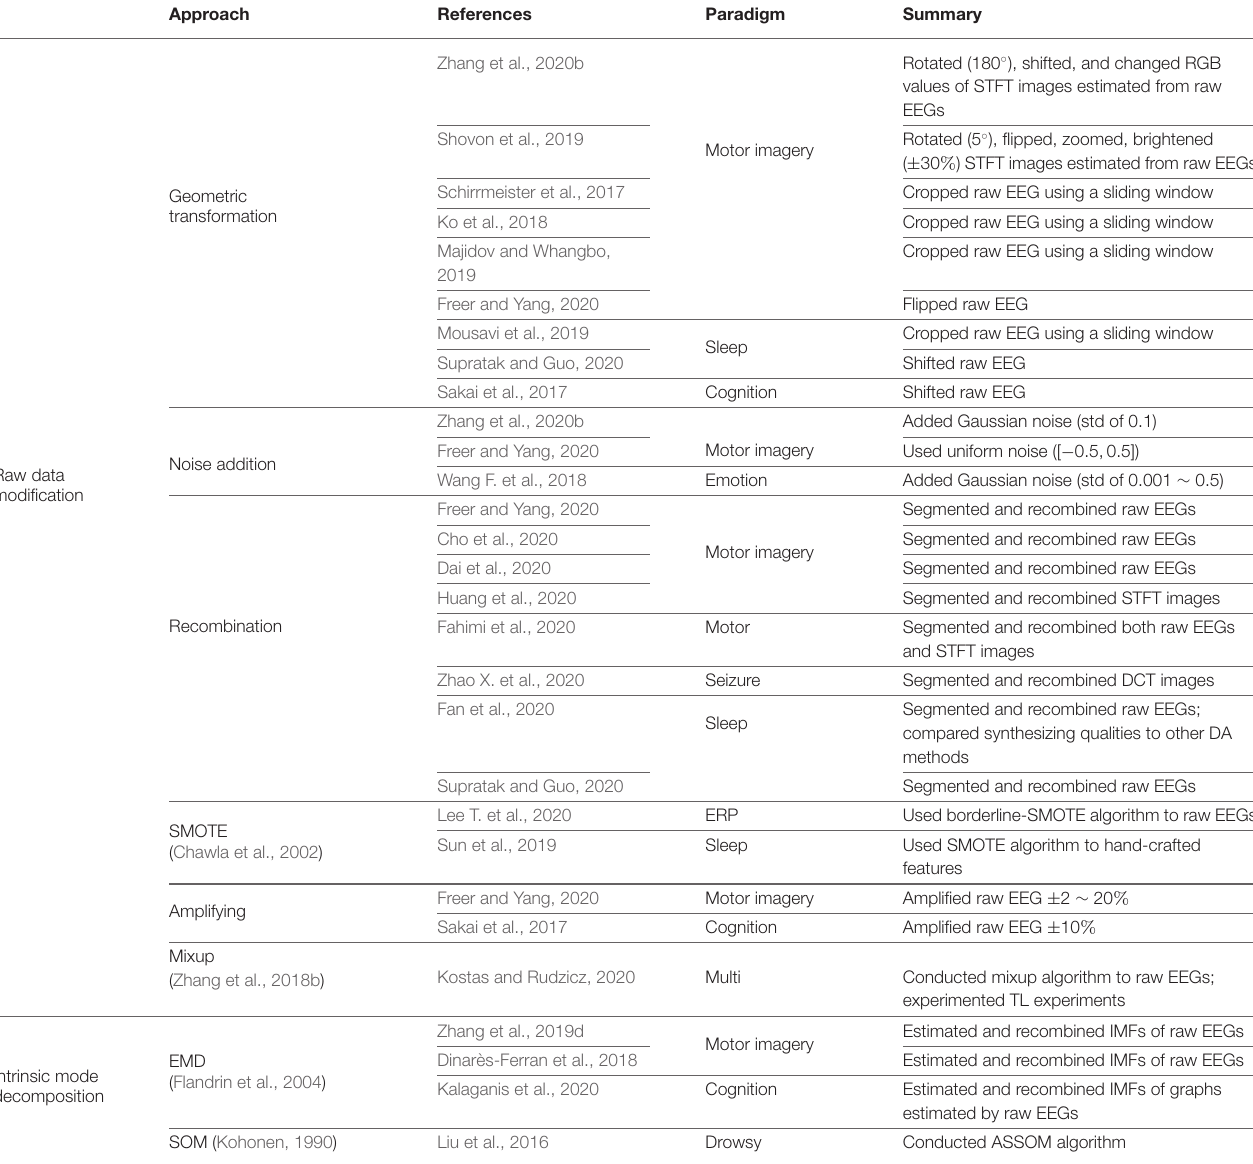
TABLE 1 | Geometric manipulation data augmentation